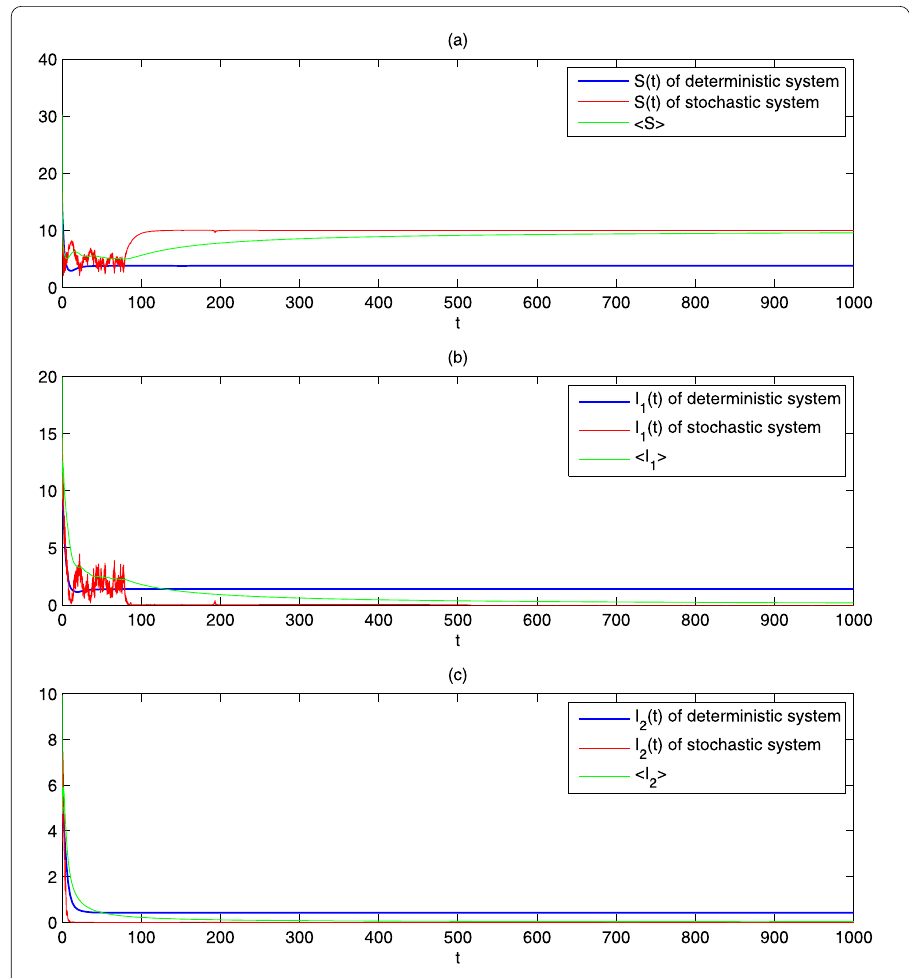
Figure 3 Dynamic behaviour comparisons of S ( t ), I 1 ( t ), I 2 ( t ) in the deterministic and the stochastic SIS system with parameters A = 1, d = 0.1, β 1 = 1.2, β 2 = 1.5, a 1 = 1, a 2 = 1.5, b 1 = 2, b 2 = 1, α 1 = 0.2, α 2 = 0.4, r 1 = 0.3, r 2 = 0.3, σ 1 = 1.1, σ 2 = 1.1. (a) Time series for S ( t ) and (cid:5) S ( t ) (cid:6) . (b) Time series for I 1 ( t ) and (cid:5) I (cid:6) . (c) Time series for I (cid:5) I (cid:6) 1 ( t ) 2 ( t ) and 2 ( t )